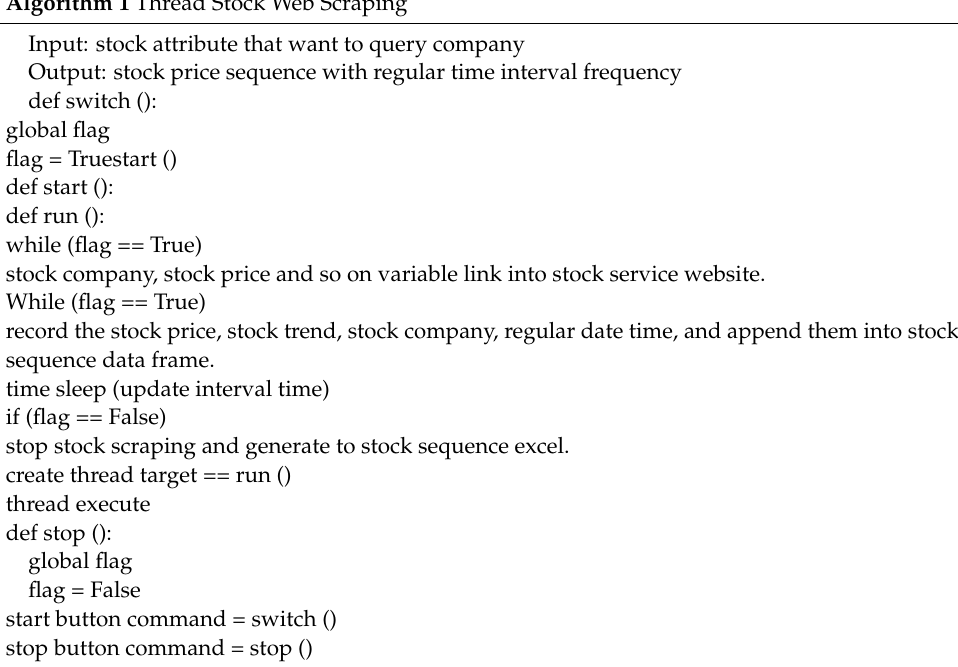
Algorithm 1 Thread Stock Web Scraping